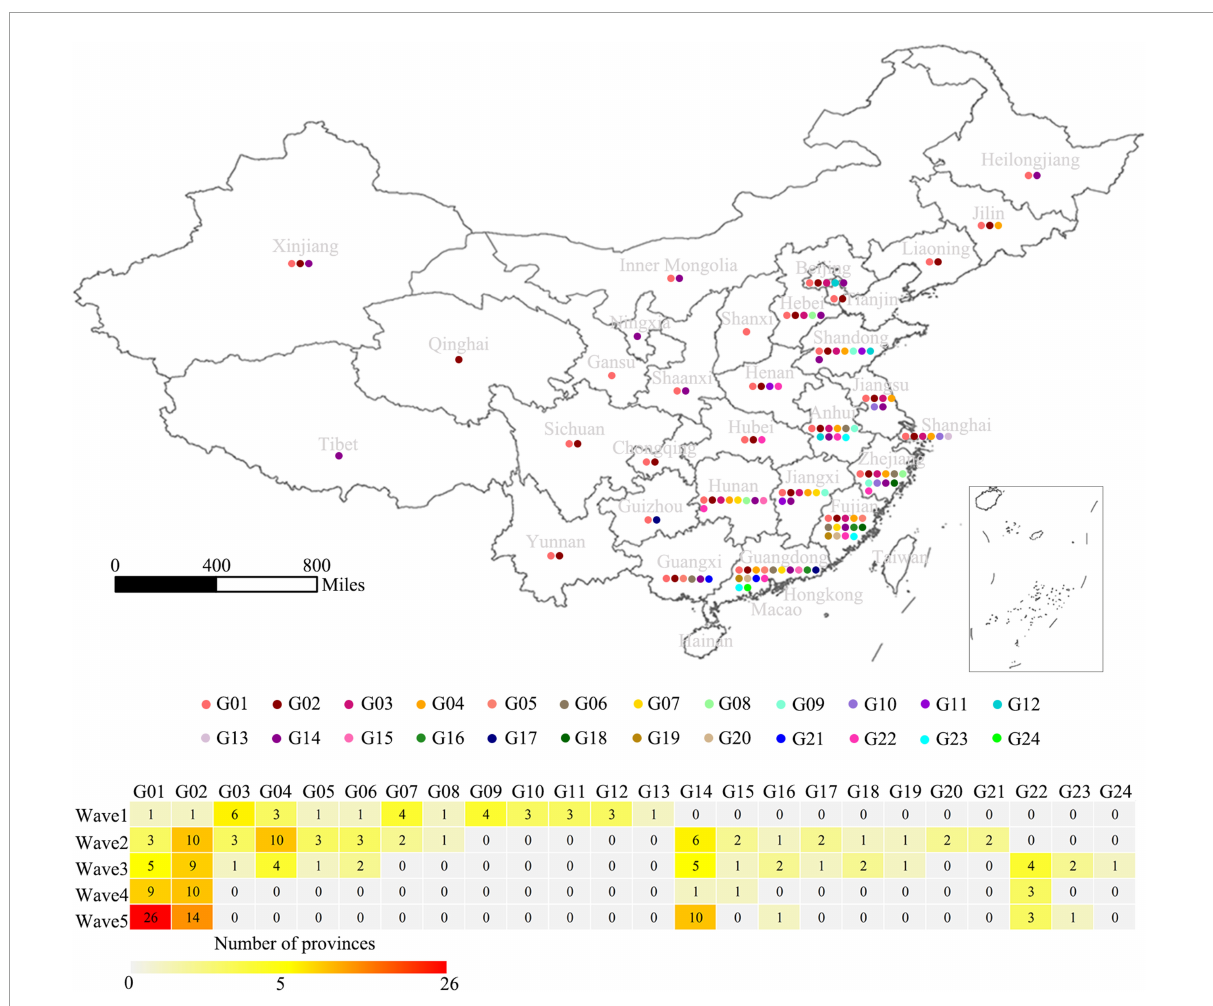
FIGURE5 Geographical distribution of the 24 genotypes of the H7N9 viruses. The 24 genotypes are indicated by colored dots on the map of China at a provincial level. The table shows the number of affected provinces by each genotype during Wave